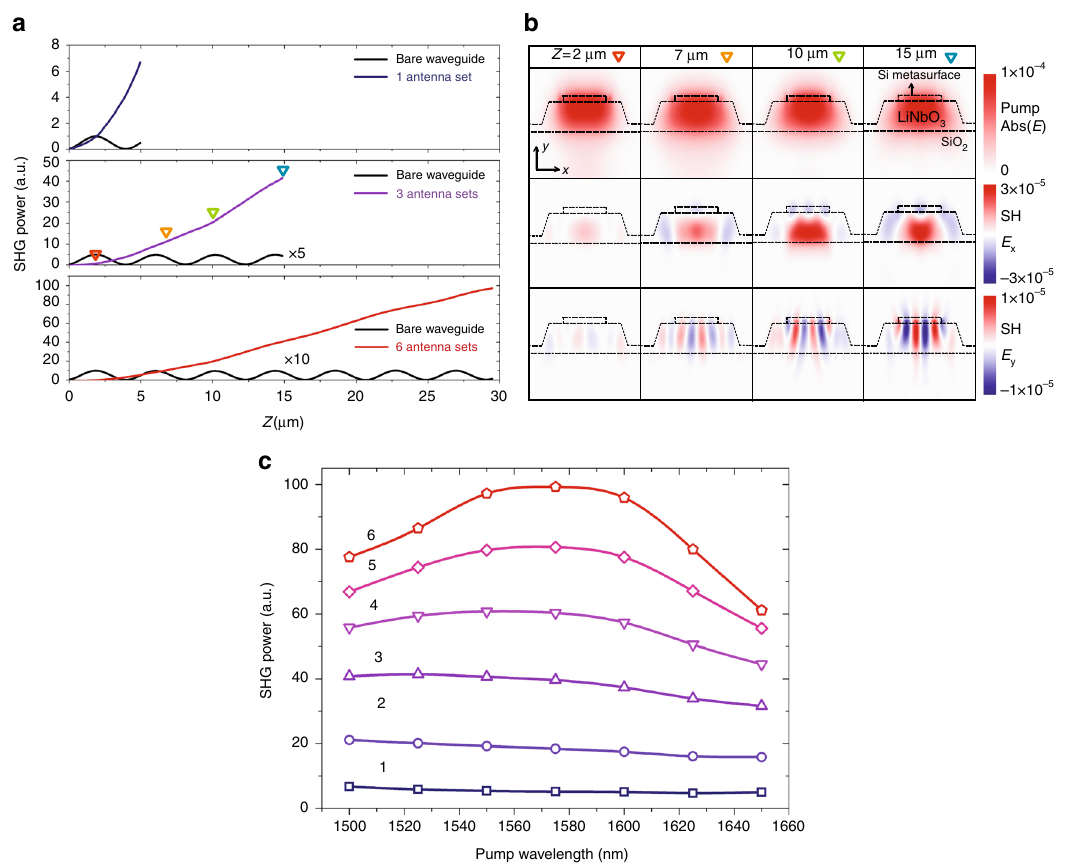
Fig. 2 Numerical simulation. a Simulations showing that the second harmonic (SH) signal increases monotonically as the number of phased antenna arrays increases. Without the antenna arrays, the SH signal oscillates periodically along the waveguide (black curves). The colored triangles in the middle panel indicate the positions of the simulated cross-section pro fi les shown in b . b Simulations showing the evolution of the pump and the SH signal as they propagate along the waveguide. It can be seen that the pump stays in the fundamental waveguide mode, TE 00 ( ω ) ( fi rst row), while the SH is gradually coupled into higher-order waveguide modes by the gradient metasurface (second and third row). c Simulations showing that the SH power increases as the number of the phased antenna arrays (labeled 1 – 6) increases and that the second harmonic generation (SHG) process is broadband (i.e., ef fi cient SHG is observed over a wide range of pump wavelengths). The broadband performance is achieved because the unidirectional effective wavevector provided by the gradient metasurface breaks the symmetry of coupling between the pump and the SH signal so that optical power is transferred preferentially from the pump to the SH signal while the inverse process is highly inef fi cient. The discrete symbols represent numerical simulation results, and are connected using spline function to better illustrate the